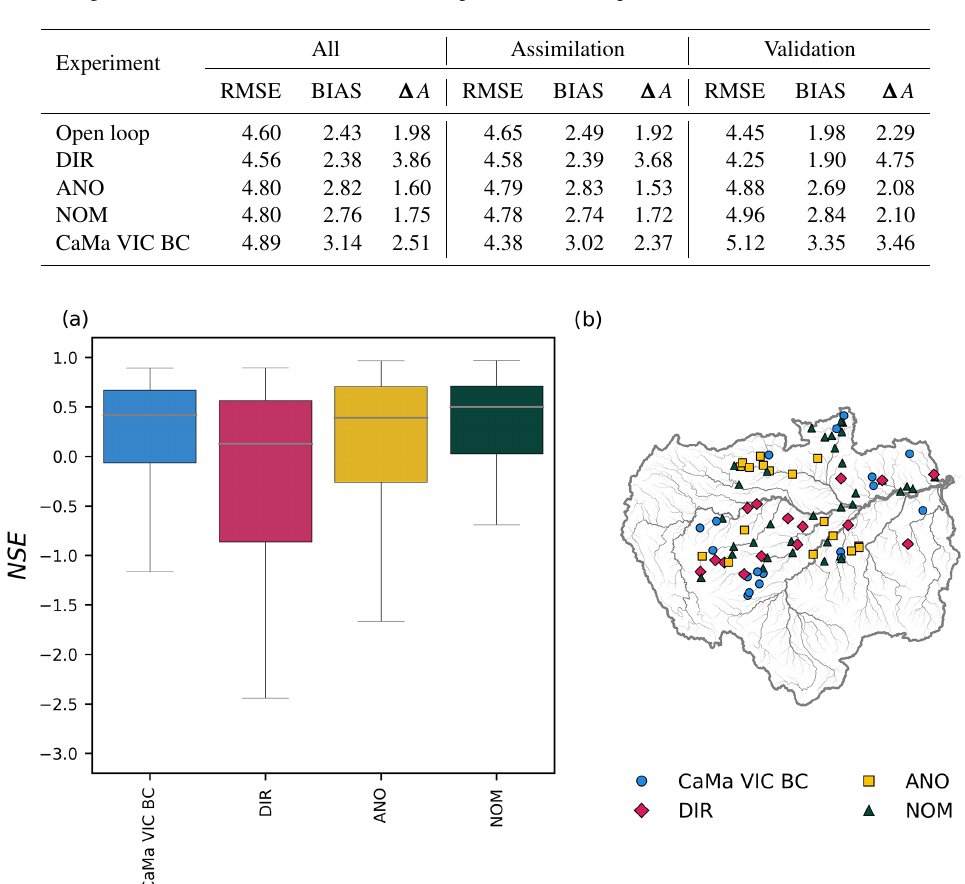
Table 4. Median performance metrics for water surface elevation estimates obtained from DA experiments. Median values for the root mean square error ( RMSE ) , long-term bias ( BIAS ) , and difference in amplitude ( (cid:49) A) are presented for all, assimilation, and validation VSs.